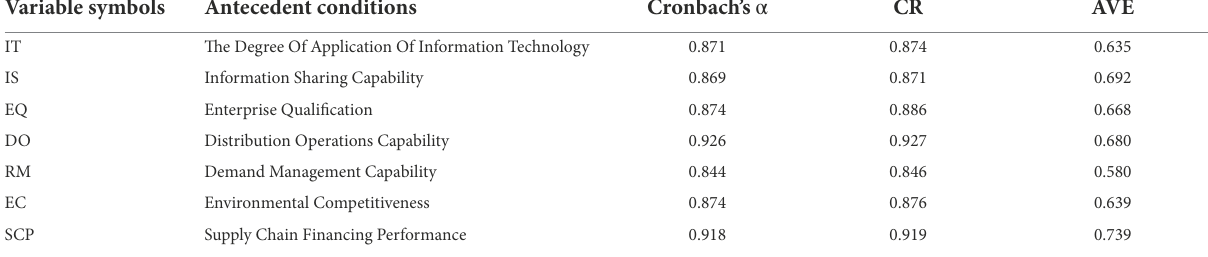
TABLE 2 Reliability test of each variable ( N = 90).